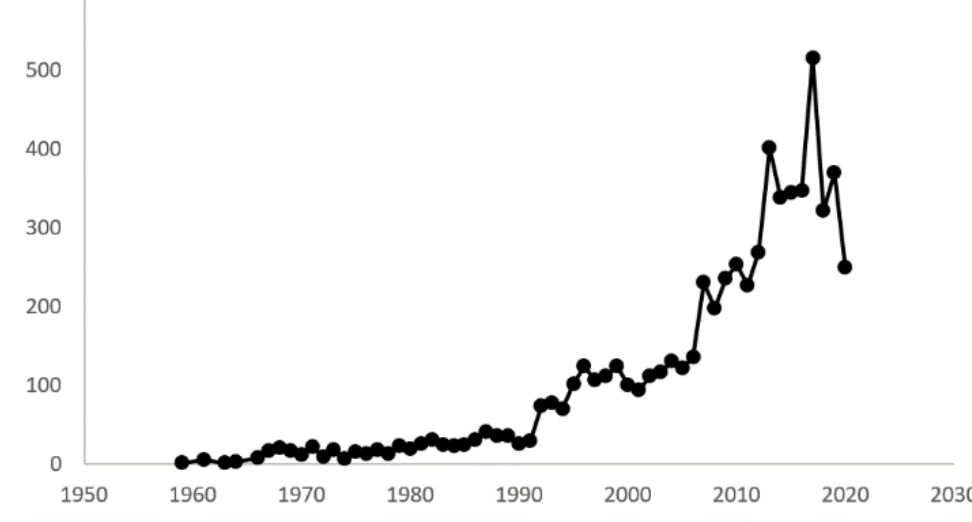
Figure 2. Number of economic development publications over time.